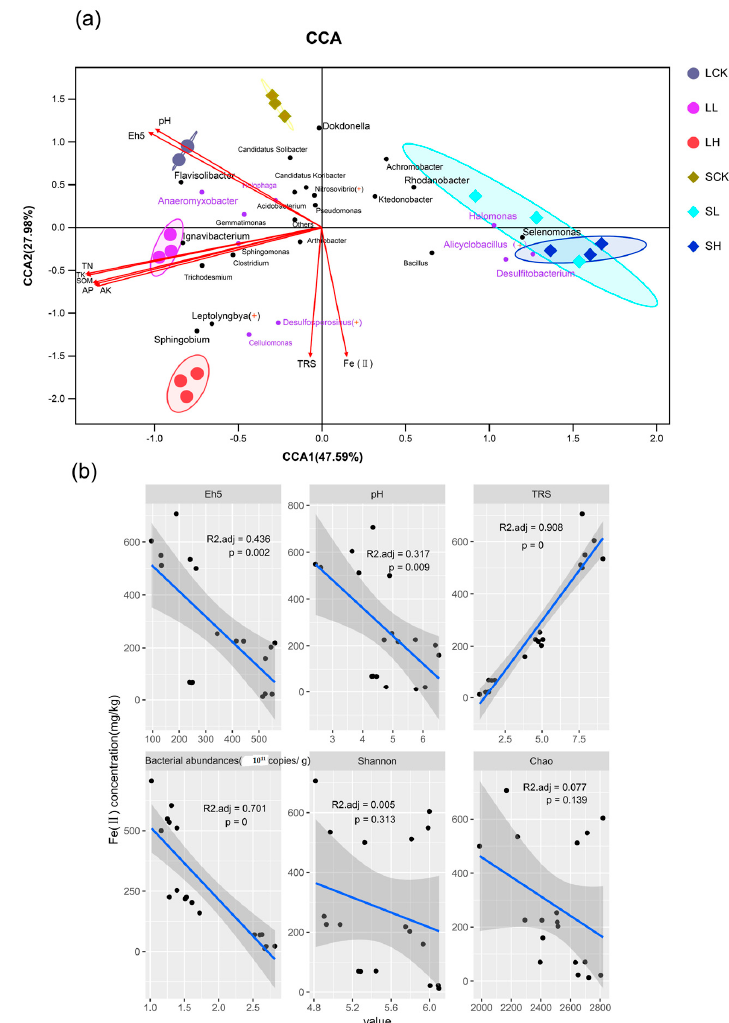
Figure 5. Relationships between bacterial communities and soil physicochemical properties. ( a ) Canonical correspondence analysis (CCA) of taxa (relative abundance of the dominant genera represented by more than 1% in at least one sample) and eight environmental parameters (pH, Eh5, TRS, AP, AK, TK, TN and SOM). TRS, total reduced substances; AP, available phosphorus; AK, available potassium; TN, total nitrogen; SOM, soil organic matter ( a ). Node colored by the category of anaerobic or other taxa, and the shape of the node is divided into chemoautotrophic and other taxa. The dot and genus name colored by purple represent anaerobic bacteria, while the genus name marked “+” represents chemoautotrophic bacteria. ( b ) General linear mixed models: correlations between Eh5, pH, TRS, total bacterial abundances (16S rRNA gene abundances), bacterial community diversity (Shannon index), bacterial community richness (Chao index) with the Fe(II) concentration. Lines in all panels show linear regression